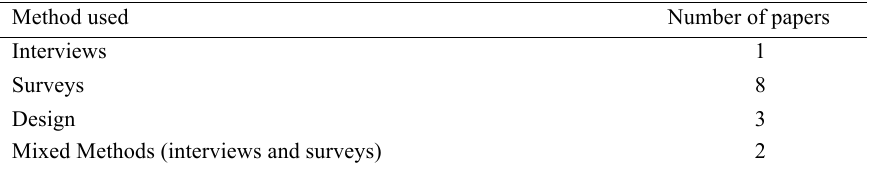
Table 6. Breakdown of empirical methods in the 20 most recently published papers between 2013 and 2014 Method used Number of papers Interviews 1 Surveys Design Mixed Methods (interviews and surveys)